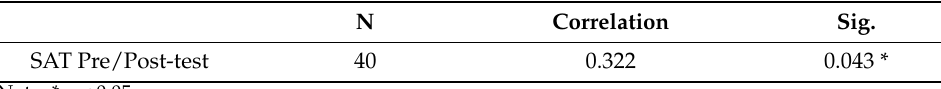
Table 9. Paired sample correlations of SAT.